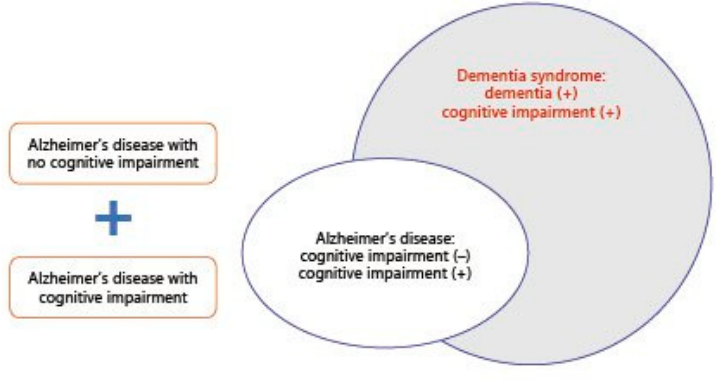
Figure 1. Scope of Alzheimer’s disease and dementia syndrome [9].